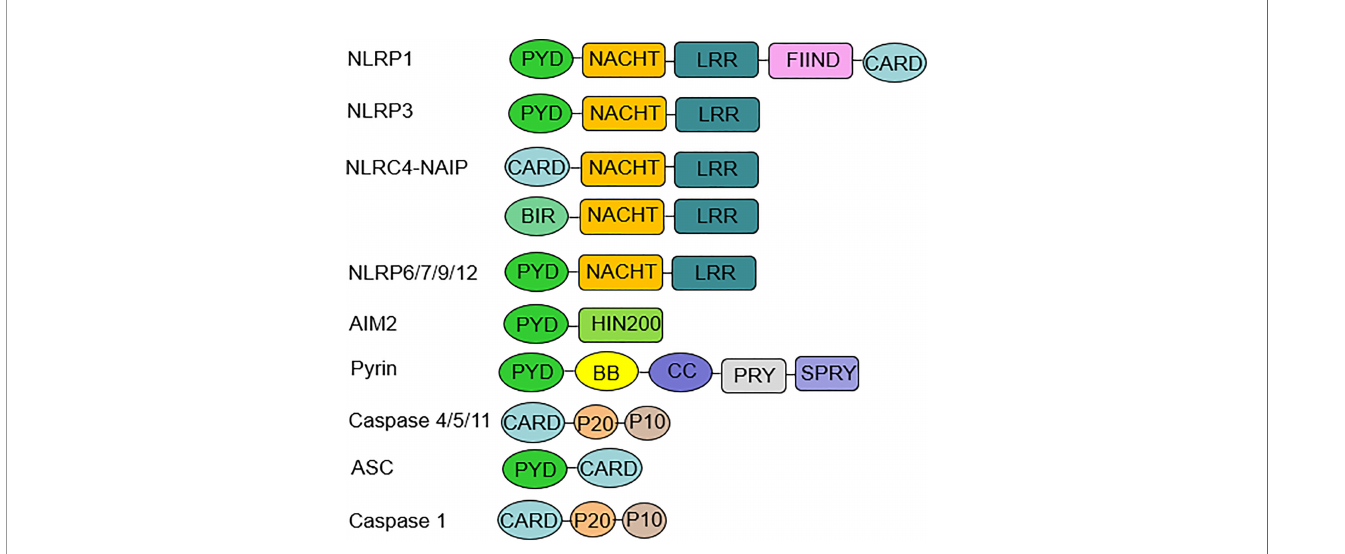
FIGURE 1 | In fl ammasome components and domain structure. In fl ammasome complexes are formed by the oligomerization of several protein domains. A typical in fl ammasome consists of three parts: a sensor molecule, the adaptor protein ASC and the effector molecule pro-caspase-1. The sensors include NLRs, AIM2, and pyrin. NLRP3, 6, 7, 9, and 12 sensors all have a PYD at the N-terminus, an NBD or NACHT in the middle, and an LRR domain at the C-terminus. AIM2 consists of a PYD at the N-terminus and a HIN-200 domain at the C-terminus. ASC is required for the formation of NLRP3, 6, 7, 9, 12, and AIM2 in fl ammasomes. ASC mediates signaling to promote pro-caspase-1 activation through homotypic PYD-PYD or CARD-CARD interactions. The NLRP1 sensor also has a PYD at the N-terminus and a CARD at the C-terminus, which can bind directly to caspase-1 independent of ASC, and NLRP1 has a unique FIIND domain that is involved in in fl ammasome activation through its own protein hydrolysis. NLRC4 has an N-terminal CARD, an intermediate NBD or NACHT, and a C-terminal LRR domain. NAIP is required for NLRC4 to recognize PAMP, and then NLRC4 self-activates and oligomerizes to form the NAIP-NLRC4 in fl ammasome. Noncanonical in fl ammasomes include human caspase-4, caspase-5, and murine caspase-11. ASC, apoptosis-associated speck-like protein containing a caspase recruitment domain; AIM2, absent in melanoma AIM2; PYD, pyrin domain; NBD, nucleotide-binding domain; CARD, caspase recruitment domain; PAMP, pathogen-associated molecular